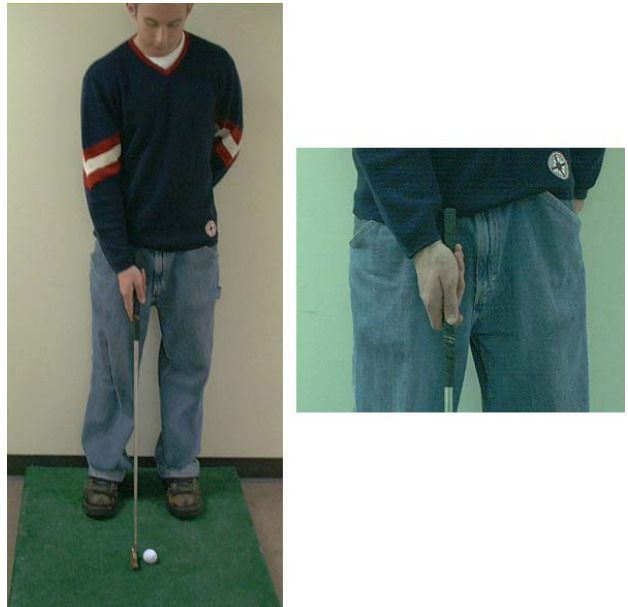
FIGURE 8 . (A) Overall view of one-handed grip for putting in a novice player (GH), where the left hand is placed behind the subject’s back. (B) Close-up view of the one-handed